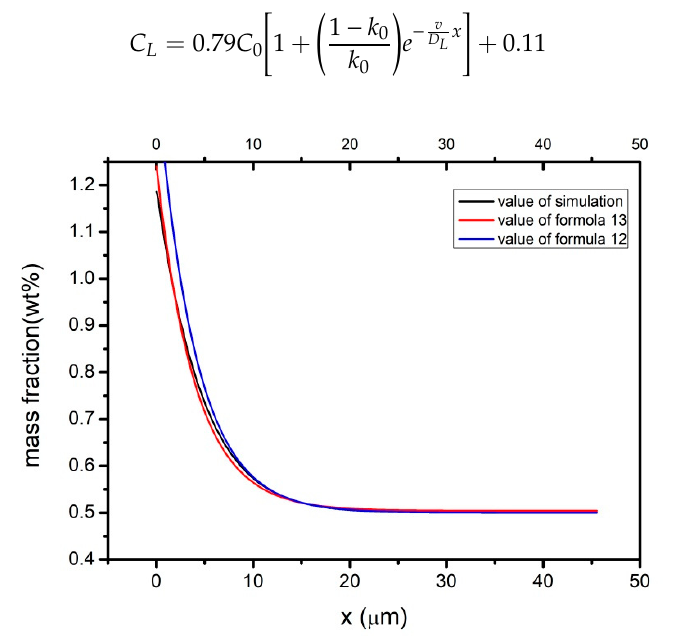
Figure 10. Solute distribution of Ti–6Al–4V–0.5Fe in the liquid phase.